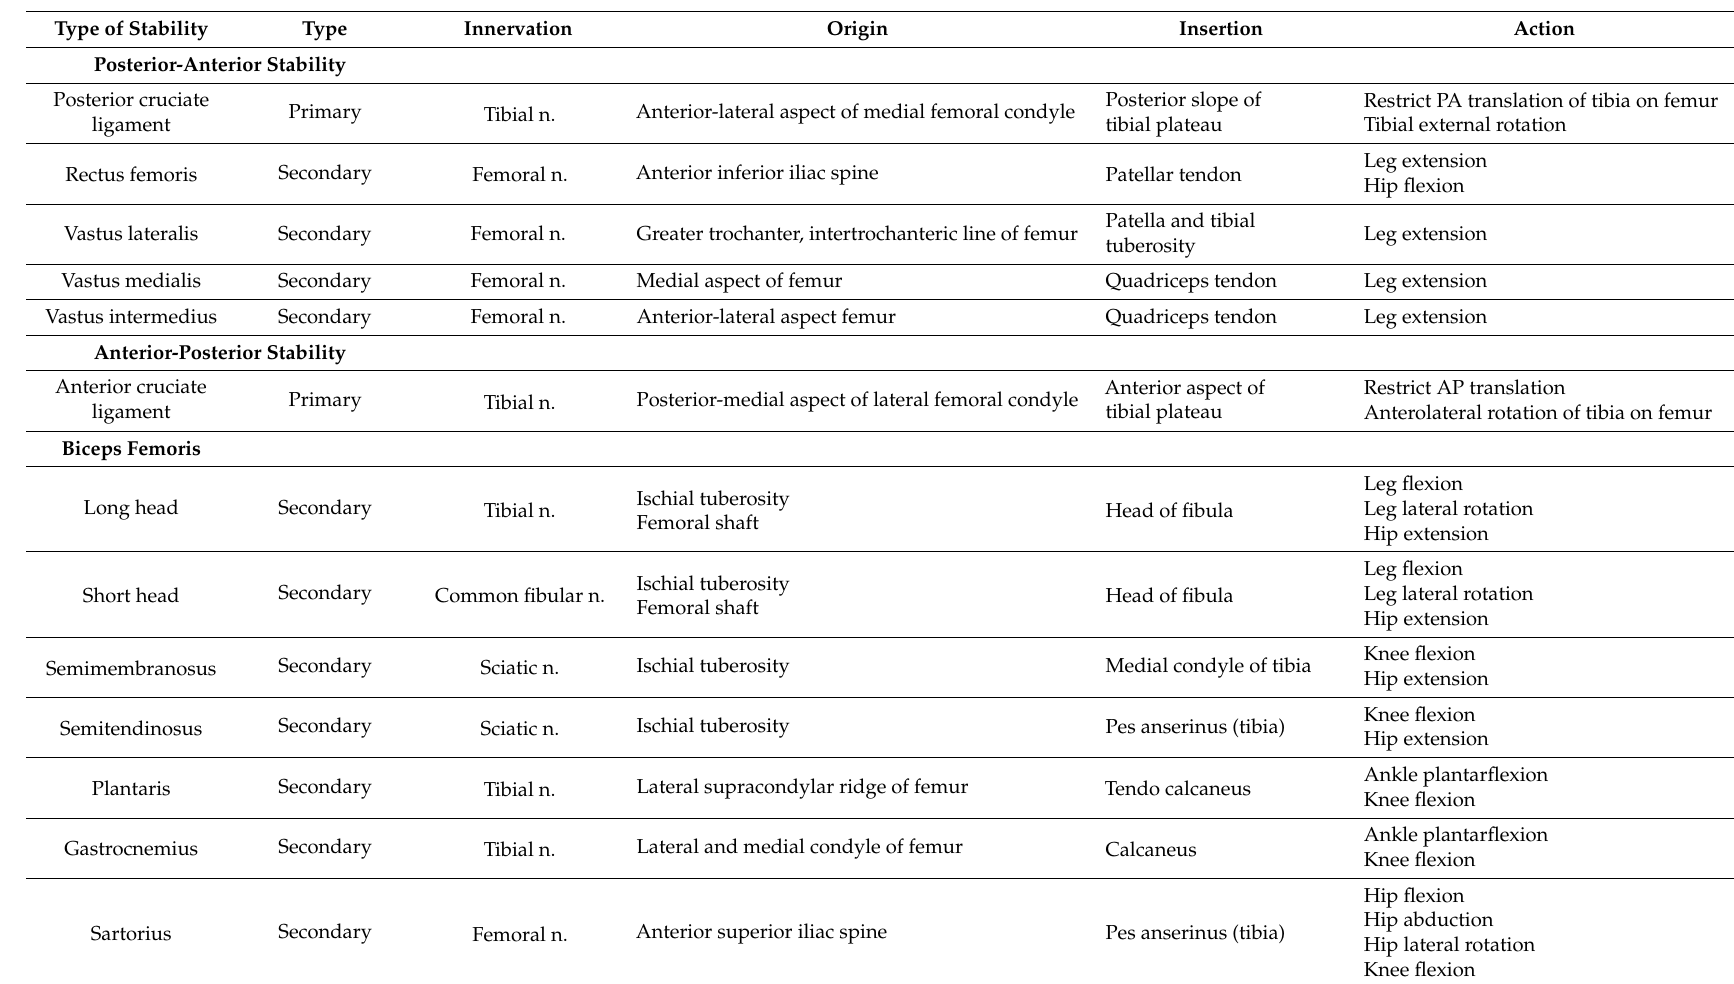
Table 1. Summary of structures contributing knee joint